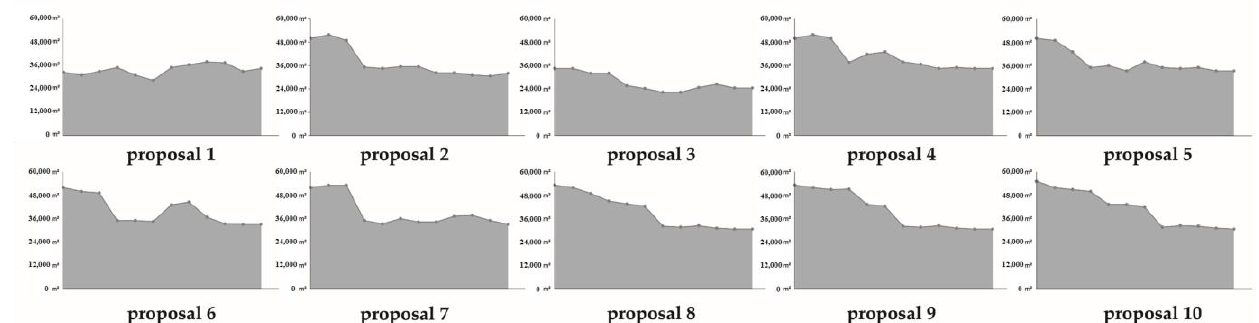
Figure 12. The area of isovist from point A to B in 10 representative urban design proposals.